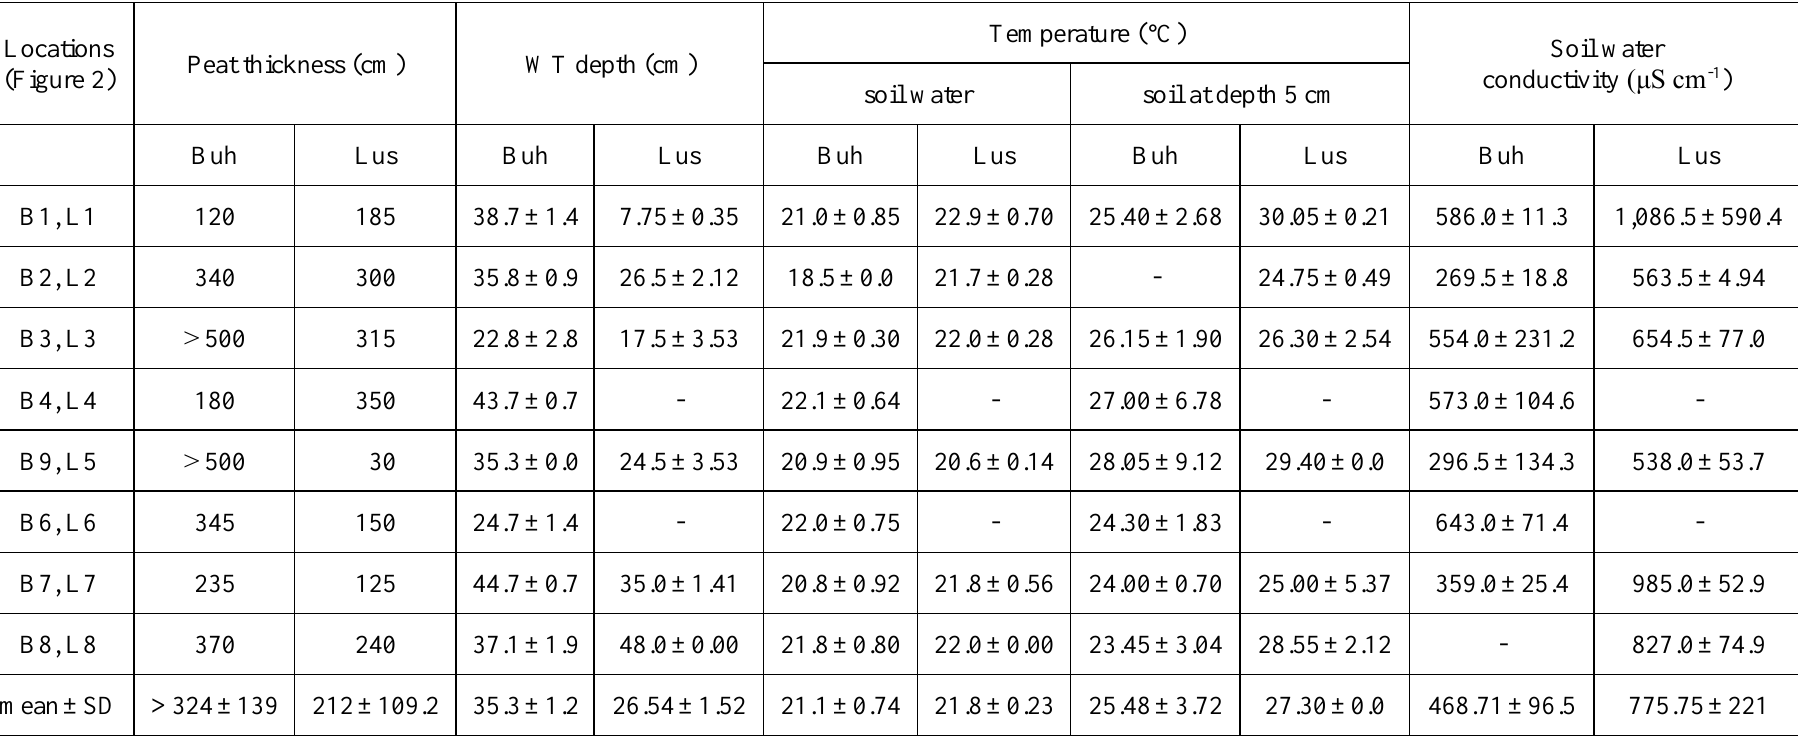
Table A1. Some physicochemical attributes measured at the sampling locations on the Buhandanda (Buh) and Lushula (Lus) peatlands. All measurements except peat thickness were repeated twice between February and April 2018 (n = 3) and the data shown are means ± SD. Temperature and conductivity were measured using a coupled probe inserted directly into the peat soil or into the water contained in the pre-installed PVC tubes in which WT depth was